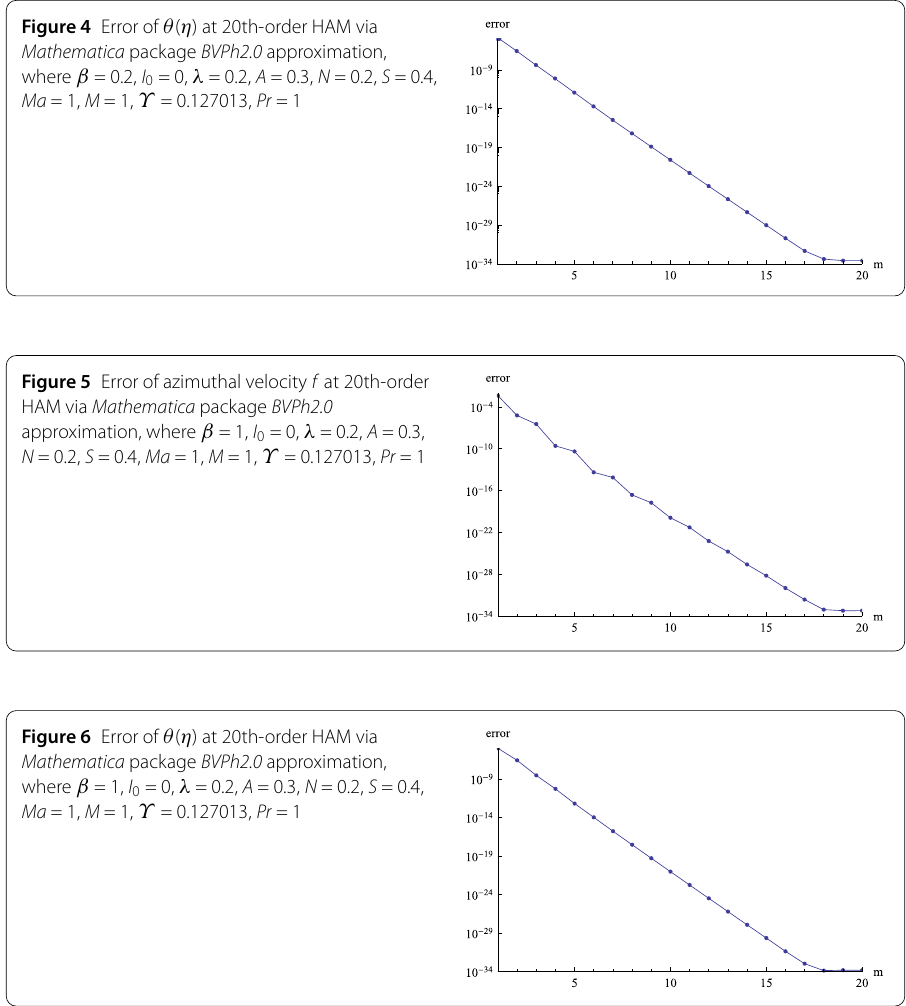
Figure 4 Error of θ ( η ) at 20th-order HAM via Mathematica package BVPh2.0 approximation, where β = 0.2, I 0 = 0, λ = 0.2, A = 0.3, N = 0.2, S = 0.4, Ma = 1, M = 1, Υ = 0.127013, Pr = 1